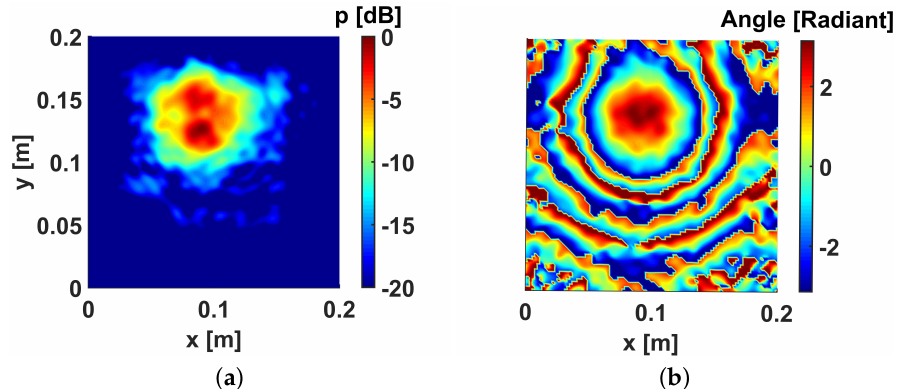
Figure 4. Amplitude ( a ) and angle ( b ) at the top of the wooden particleboard without a flaw. Evaluated with the spec-radiation method for the frequency 50kHz, with d x = d y = 2 mm and a grid of the size 101 × 101 points.